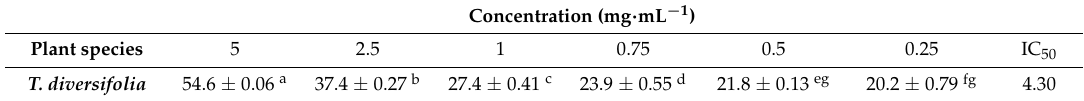
Table 10. %AA values of the essential oil of the leaves of T. diversifolia